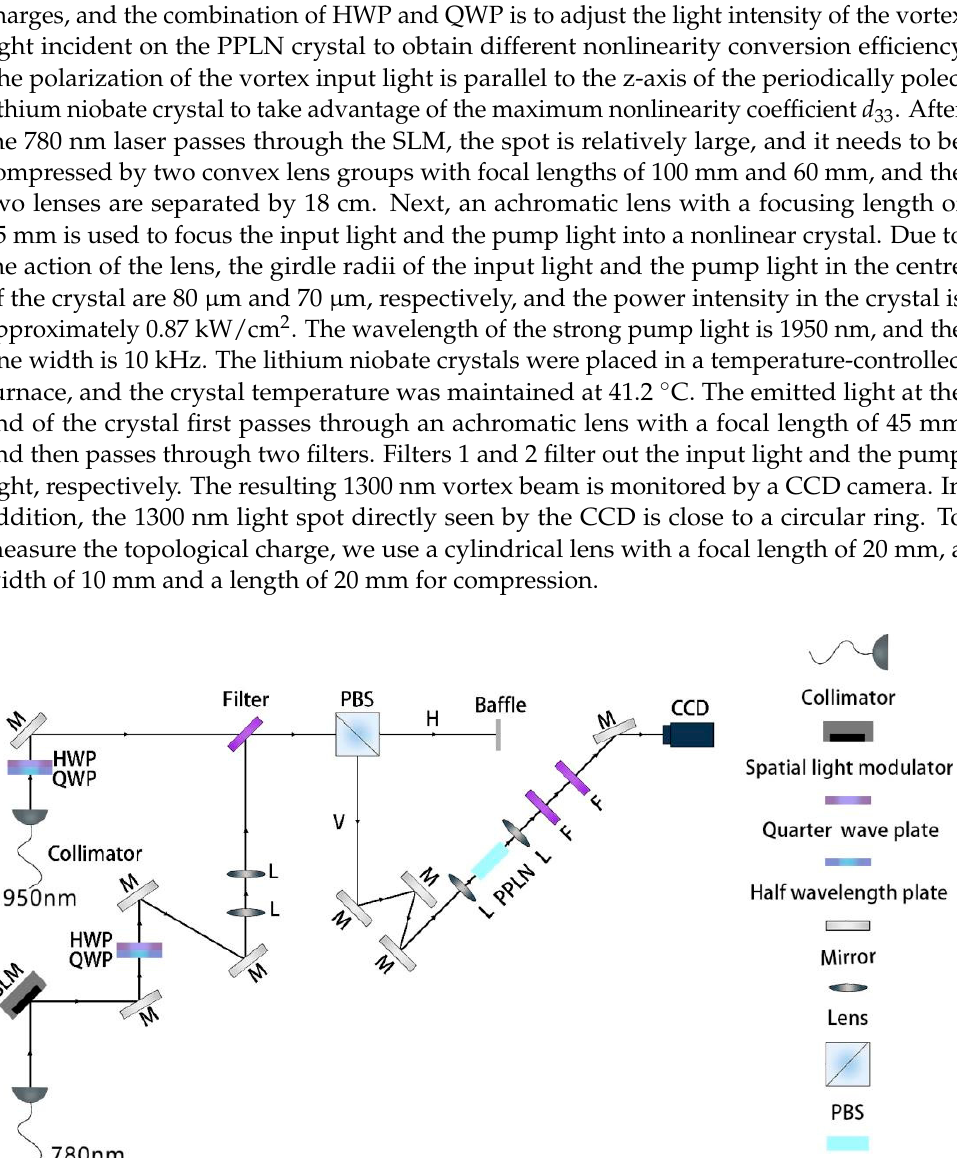
Figure 2. Experimental optical path diagram showing the helical phase profile loaded on the SLM to generate vortices. Key components (abbreviations) include combiner, half-wave plate (HWP), PPLN, PBS, quarter-wave plate (QWP), CCD, baffle, filter, mirror (M), lens (L1–L4), and spatial light modulator (SLM).